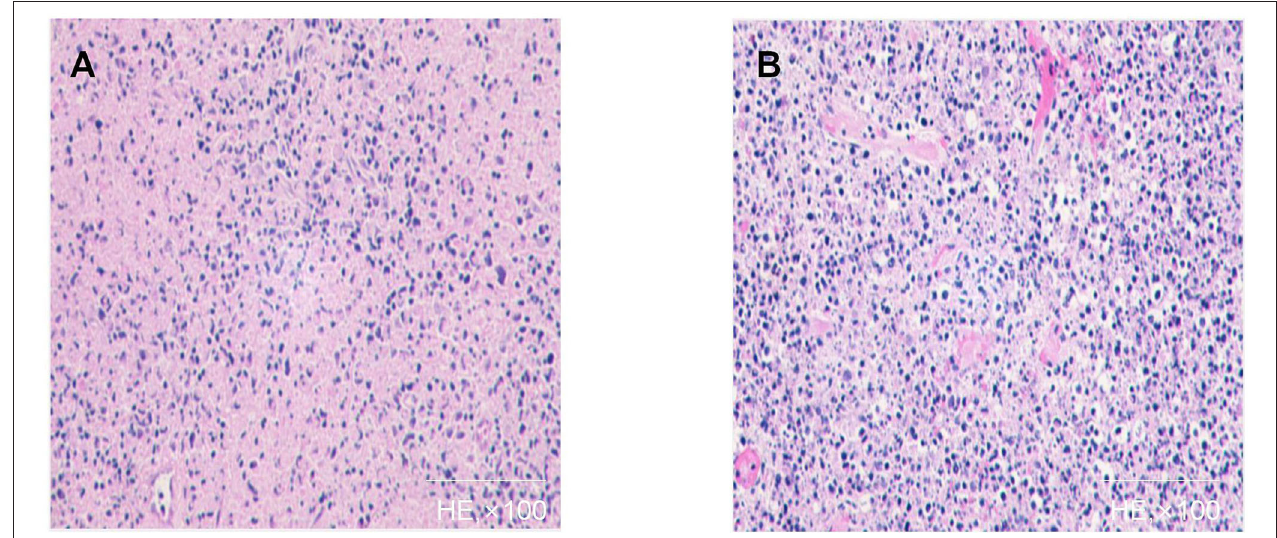
FIGURE 1 | Histopathology of affected lymph node of case 1 (A,B) : Patchy circumscribed areas with eosinophilic fibrinoid necrosis in the paracortex and cortex and absence of granulocytes in the areas of necrosis are shown. A variety of cells surround the necrotic area, and a large number of apoptotic cell fragments exist outside the cells.